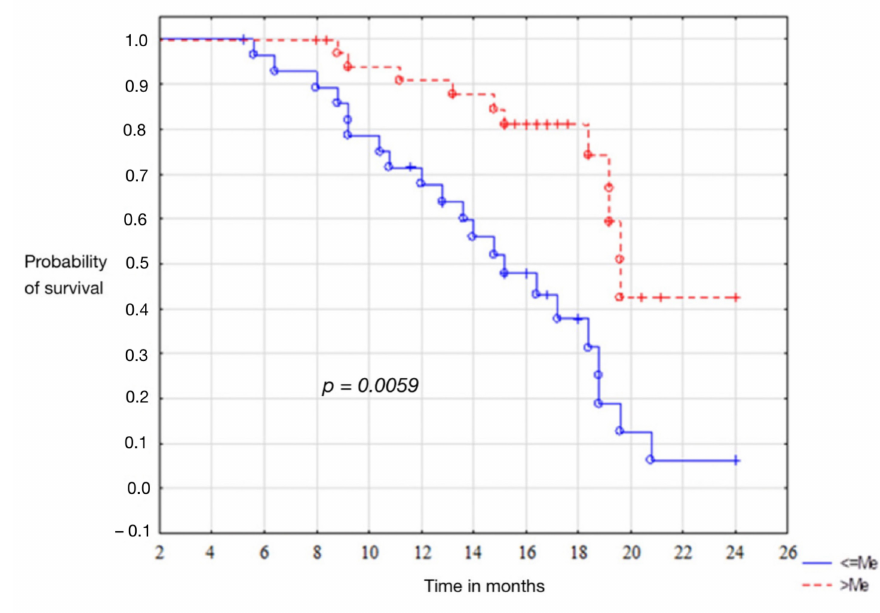
Figure 2. Kaplan-Meier curves for recurrence of endometrial cancer patients.